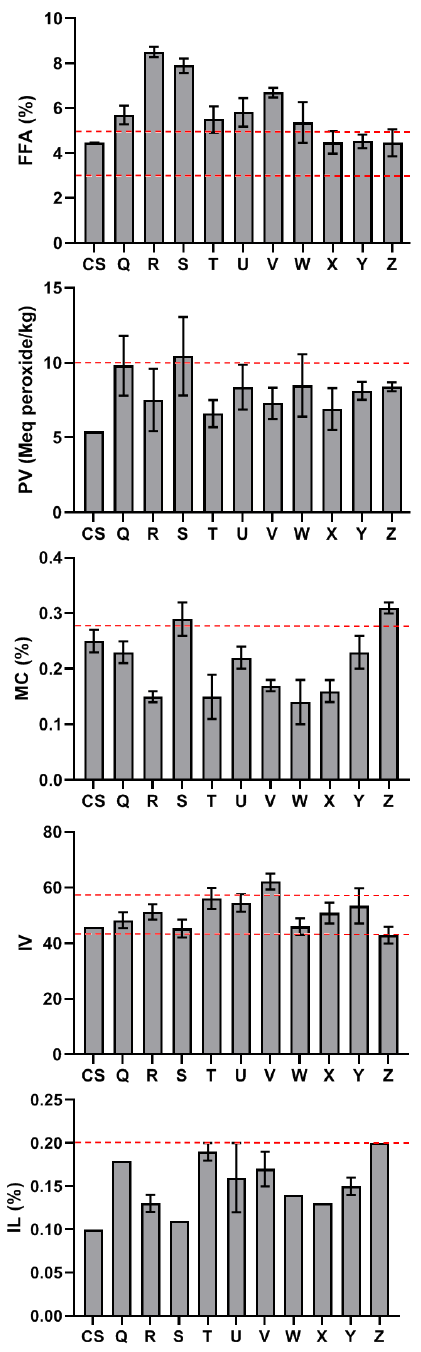
Figure 1. Physical and chemical analysis of processed palm oil samples. The red dashed lines represent the permissible limits according to the Standards Organization of Nigeria (SON). FFA: free fatty acid, MC: moisture content, PV: peroxide, IV: iodine value, IC: impurity content. CS: control oil sample while other palm oil samples were sourced from